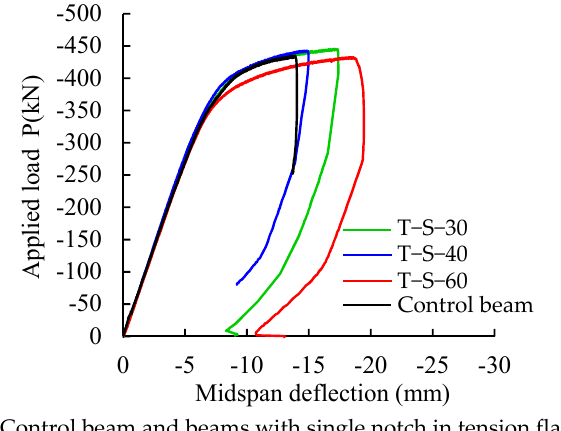
( b ) Control beam and beams with single notch in tension flange at third span.